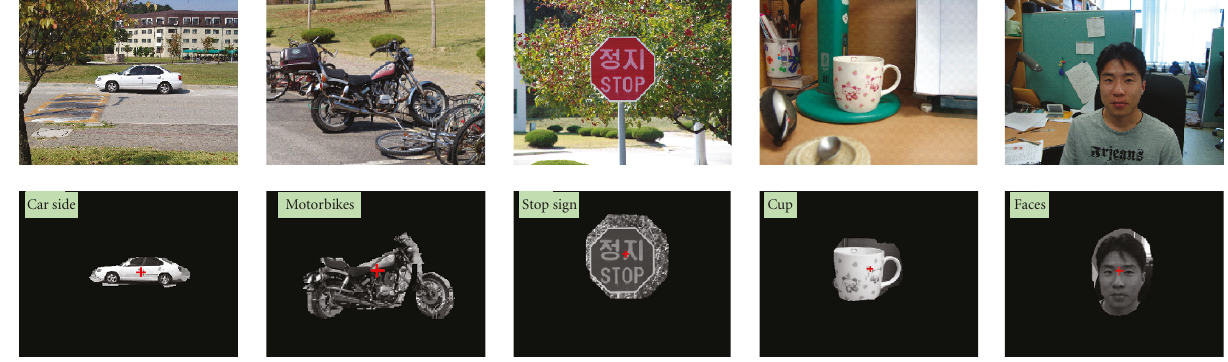
Figure 31: Categorization and segmentation results for real-world